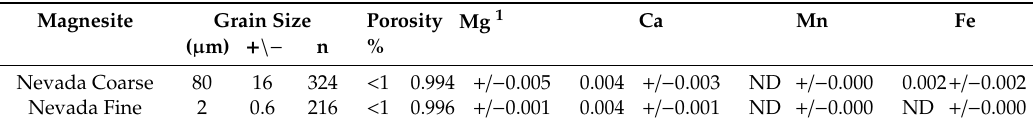
Table 1. Compositions of magnesite aggregates.